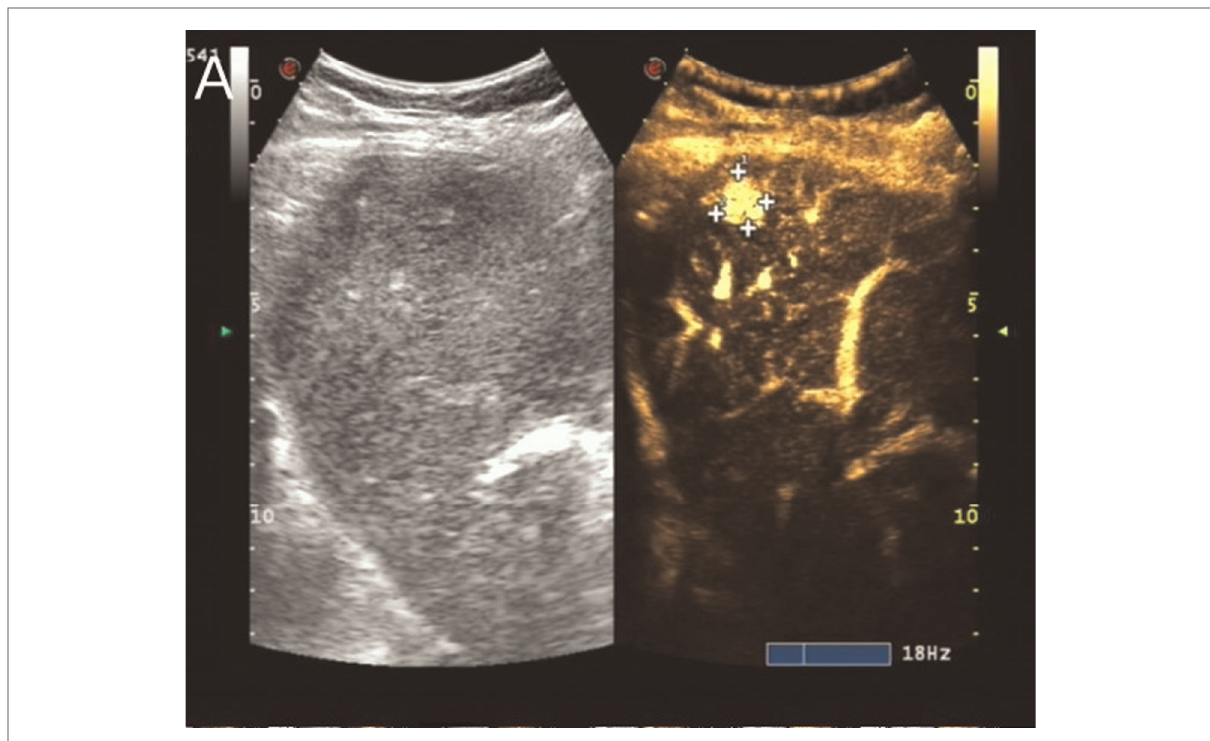
FIGURE 2 Contrast-enhanced liver ultrasound fi ndings of this case contrast-enhanced ultrasonography of the nodules in the upper segment of the right anterior lobe of the liver showing washout performance (surrounded by crosses).